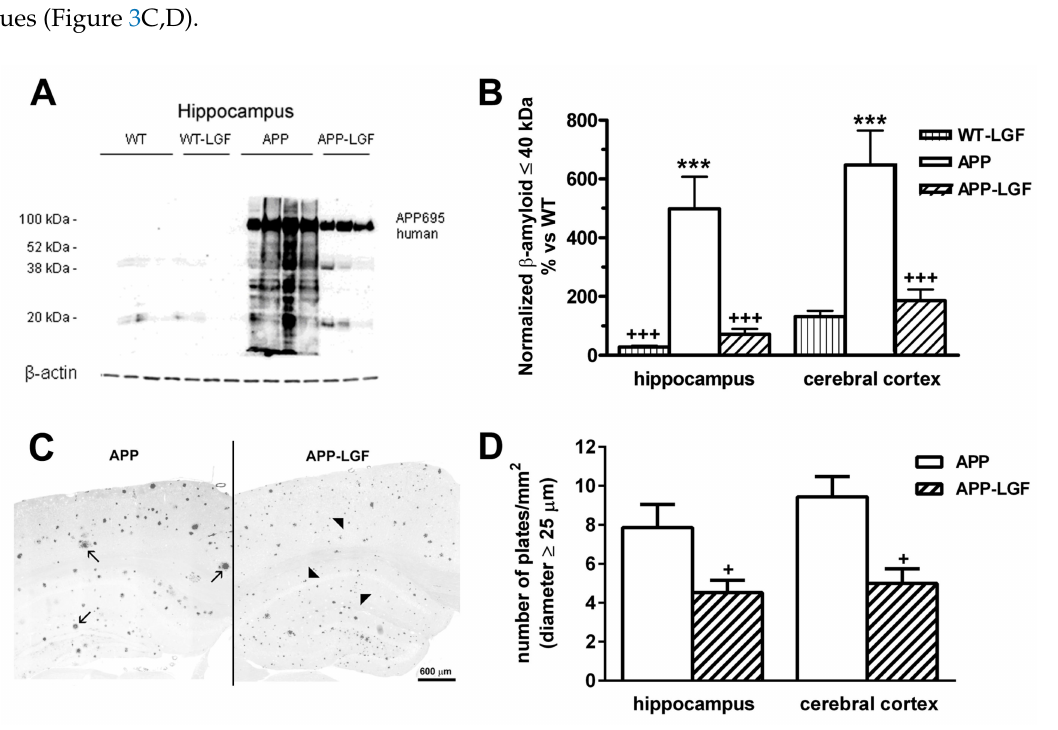
Figure 2. LGF reduces amyloid- β accumulation and the size of amyloid- β positive plaques in the hippocampus and cerebral cortex of APPswe mice. Panels ( A , B ) show a Western blot representative image of A β aggregates in the hippocampus ( A ) and the quantification of A β -aggregates ≤ 40 kDa in the hippocampus and cerebral cortex ( B ). Note that A β protein levels are up-regulatedin the hippocampus and cerebral cortex of APPswe mice and that LGF treatment significantly reduces its expression in both structures. Panel ( C ) shows a representative image of A β -positive plaques of large ( C , black arrows) and small size ( C , black arrowheads) in one hemisphere of APP mice brain (scale bar: 600 µ m). Note that in APP-LGF mice, large plaques are reduced, while small plaques increase. Panel ( D ) shows how LGF treatment significantly reduces the number of plaques with a diameter higher than 25 µ m in the hippocampus and cerebral cortex. Results represent the mean ± SEM of 7 to 8 ( B ) and 4 to 5 ( D ) independent mice in each experimental group. The statistical analysis was performed by one-way ANOVA followed by Newman–Keuls test. *** p ≤ 0.001 vs. WT. + p ≤ 0.05, +++ p ≤ 0.001 vs. APP